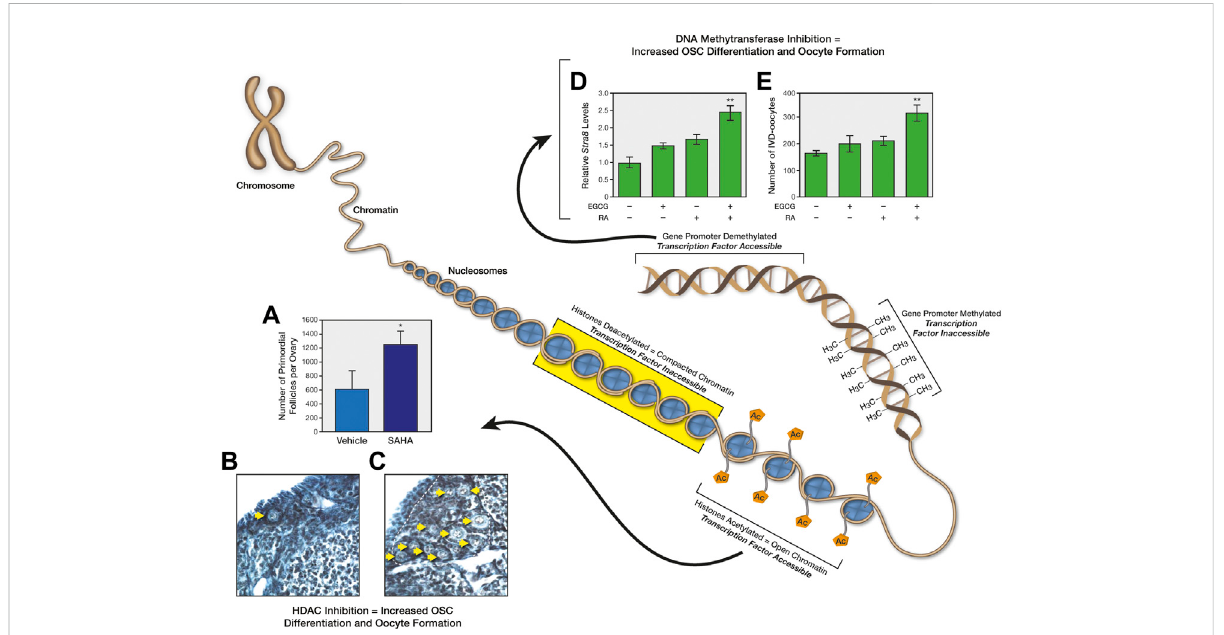
FIGURE 4 Epigenetic regulation ofOSC differentiation and postnataloogenesis.The diagramdepicts howchanges inchromatin structure, eitherthrough histone acetylation/deacetylation or DNA methylation/demethylation, controls accessibility of transcription factors to target genes, which in turn in fl uences the differentiation of OSCs into oocytes. As one example, injection of reproductively aged female mice with the histone deacetylase inhibitor, suberoylanilidehydroxamic acid(SAHA),rapidly increases primordial oocyte-containing folliclenumbersinovaries (A) ;representative ovarian sectionsof mice treated with vehicle (B) or SAHA (C) are shown for illustrative purposes, with yellow arrows highlighting the large increase in visibleprimordialfolliclesfollowingSAHAtreatment.ThesepanelsofdatawerereproducedfromWangandTilly(2010).Asanotherexample,addition of the DNA (cytosine-5)-methyltransferase 1 inhibitor, epigallocatechin-3-gallate (EGCG), to cultures of mouse OSCs sensitizes the cells to retinoic acid (RA)-induced expression of the meiosis-commitment gene, Stra8 (stimulated by retinoic acid gene 8) (D) , as well as to RA-promoted differentiation of the cells into in-vitro – derived (IVD) oocytes (E) . These panels of data were reproduced from Satirapod et al.